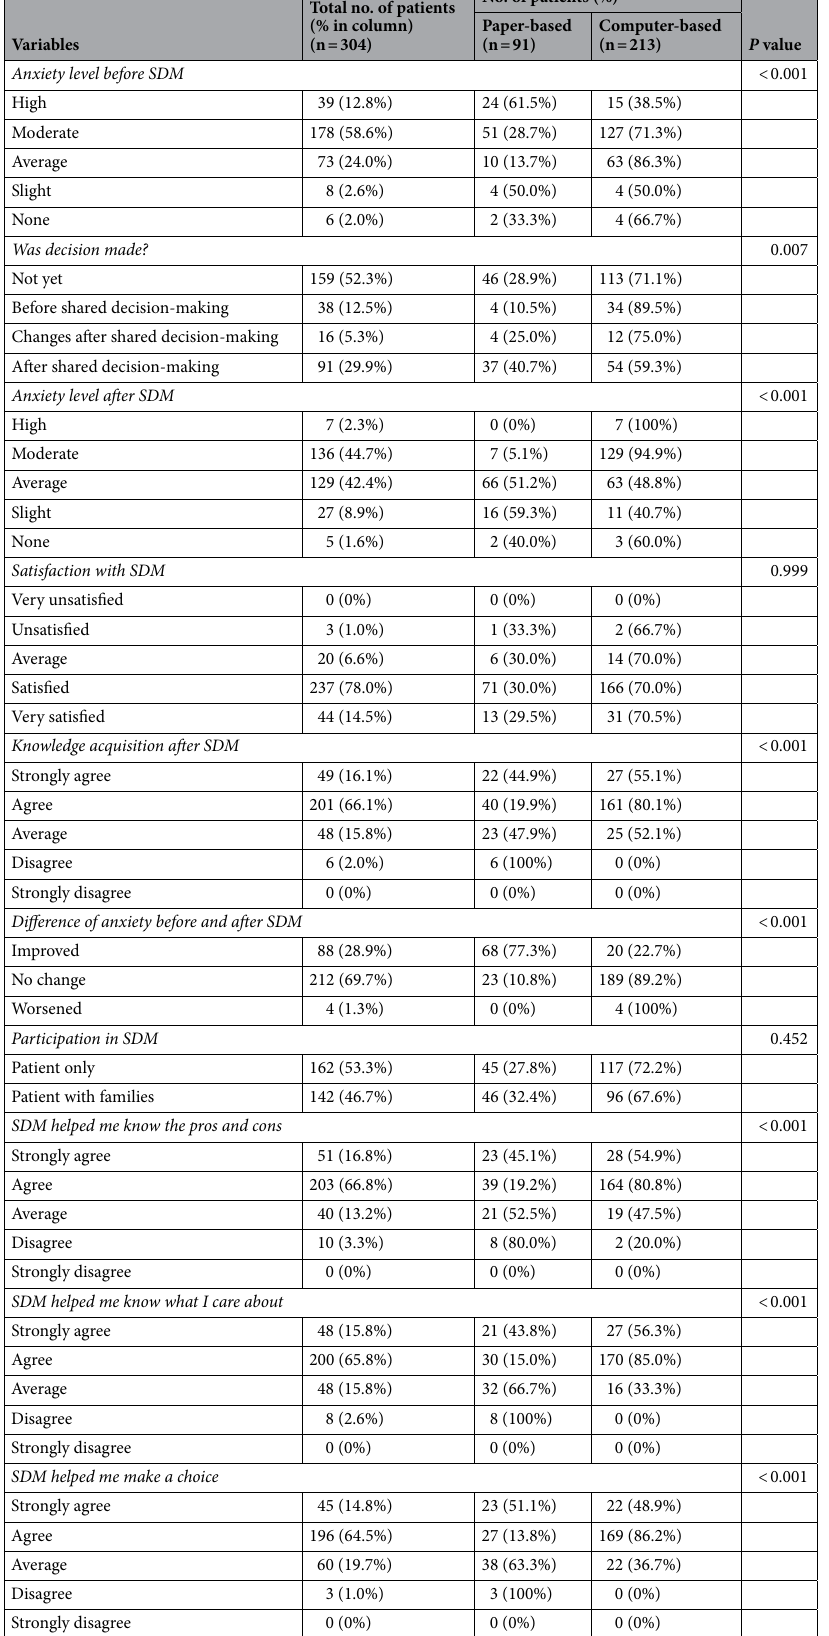
Table 2. Results of the outcome measures in patients who underwent shared decision-making (SDM) based on paper-based or computer-based methods. SDM shared